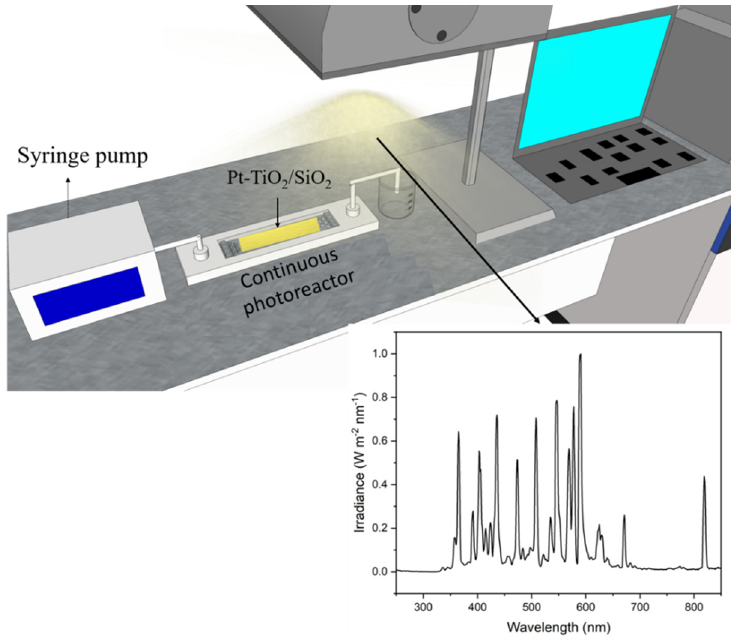
Figure 1. Schematic representation of the experimental apparatus, including the irradiance spectra measured at the reactor surface.